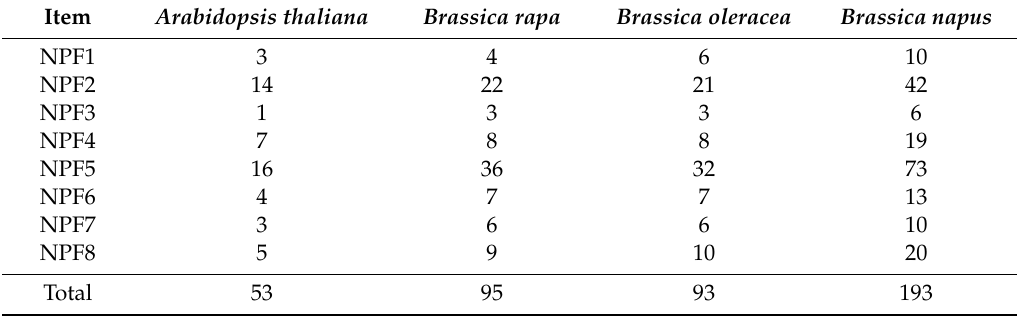
Table 1. Copy number of the NRT1 / PTR family (NPF) in Arabidopsis and three Brassica species. Item Arabidopsis thaliana Brassica rapa Brassica oleracea Brassica